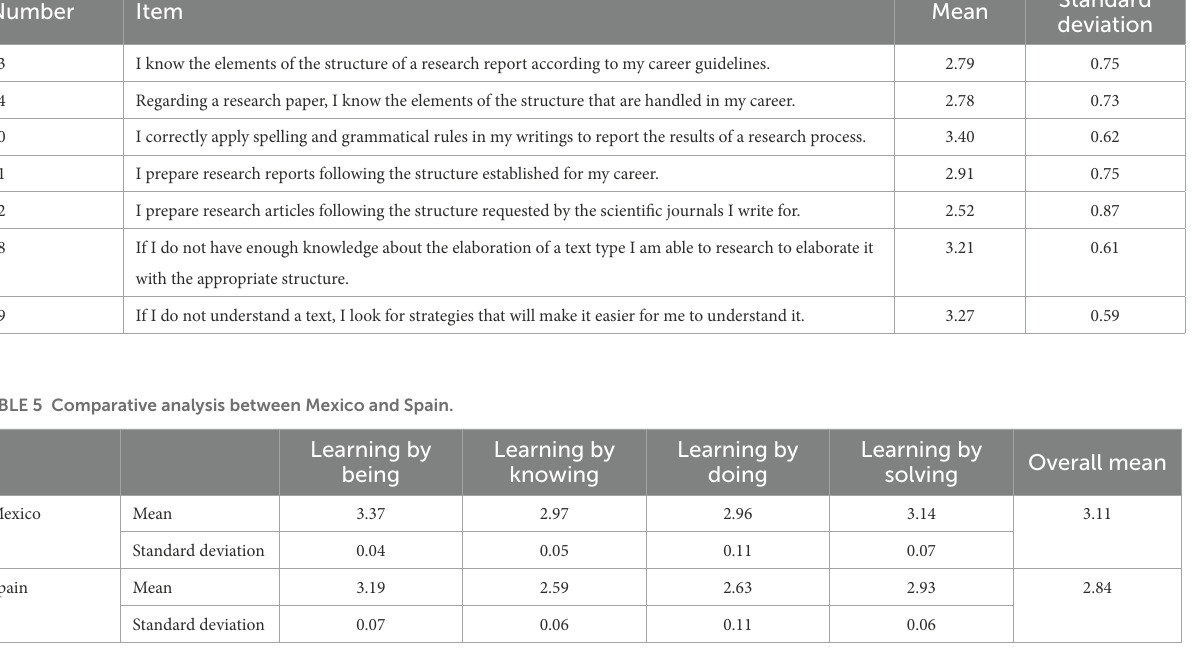
TABLE 4 Means by items corresponding to academic literacy. Number